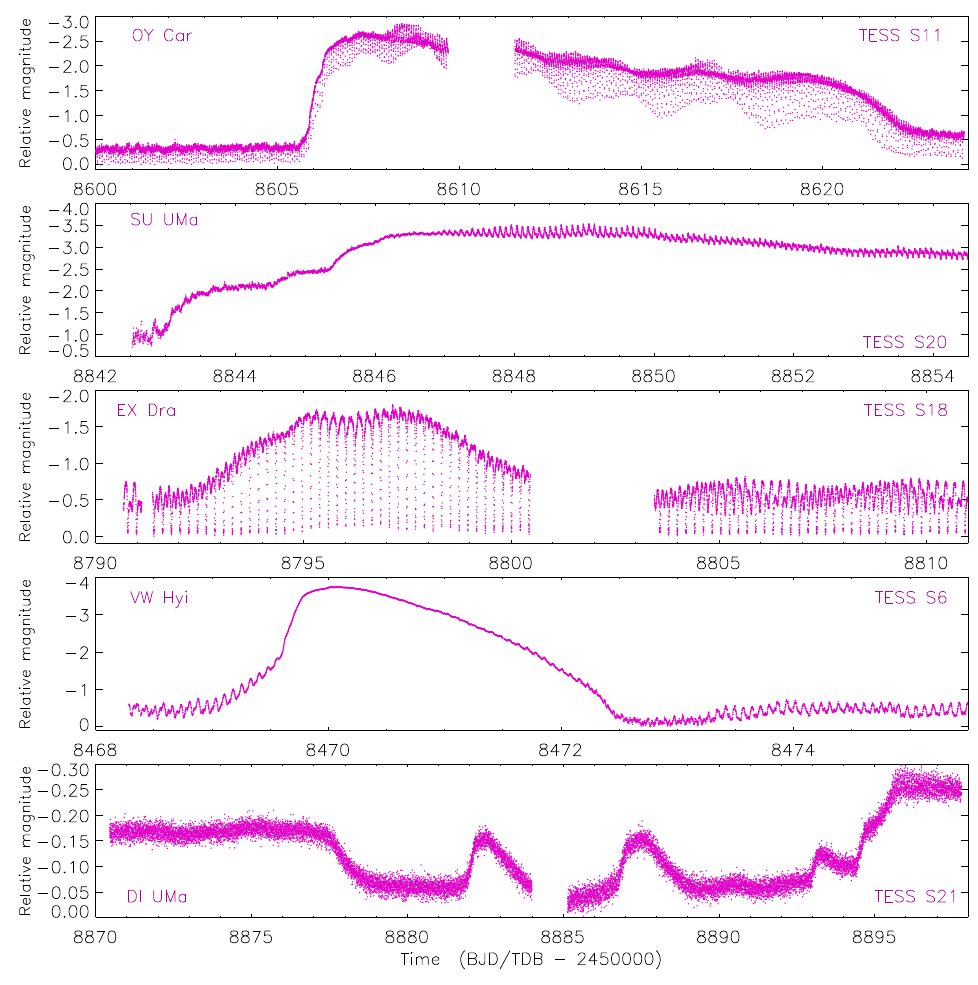
Figure 10. Example TESS light curves of CVs. The magnitude scales are not reliable due to the faintness of these objects for